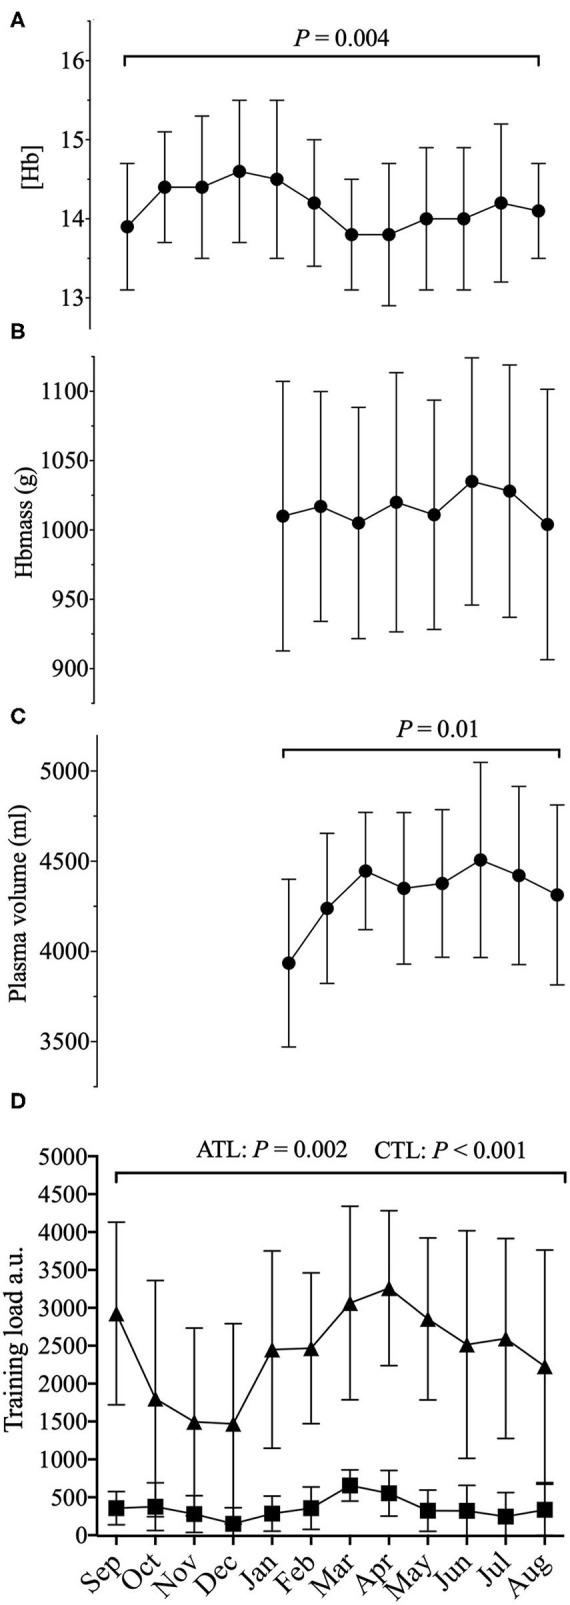
Average 12 months representation of (A) (Hb): hemoglobin concentration; (B) Hbmass: total hemoglobin mass; (C) PV: plasma volume; along with (D) training load (a.u.) (cumulated daily TSS) with acute training load (5 days, ATL) and chronic training load (42 days, CTL) before sampling; a.u.: arbitrary units. P–values for the statistical difference over the 12 months.